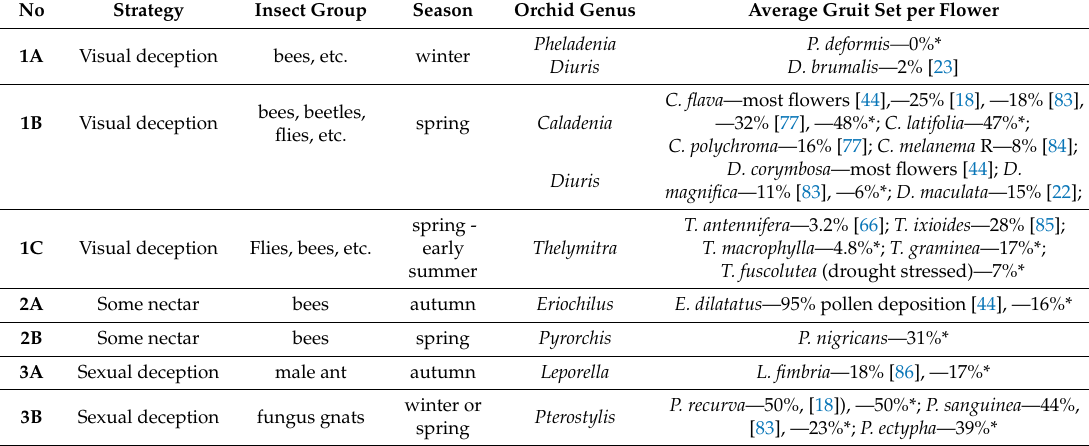
Table 1. Typical fruit set rates for common or rare ( R ) Australian orchids with di ff erent pollination strategies. Data are from studies that include substantial numbers of orchids (n > 100) and are the percentage of flowers where seedpods develop fully from natural pollination (see Table A1 for insect pollinator